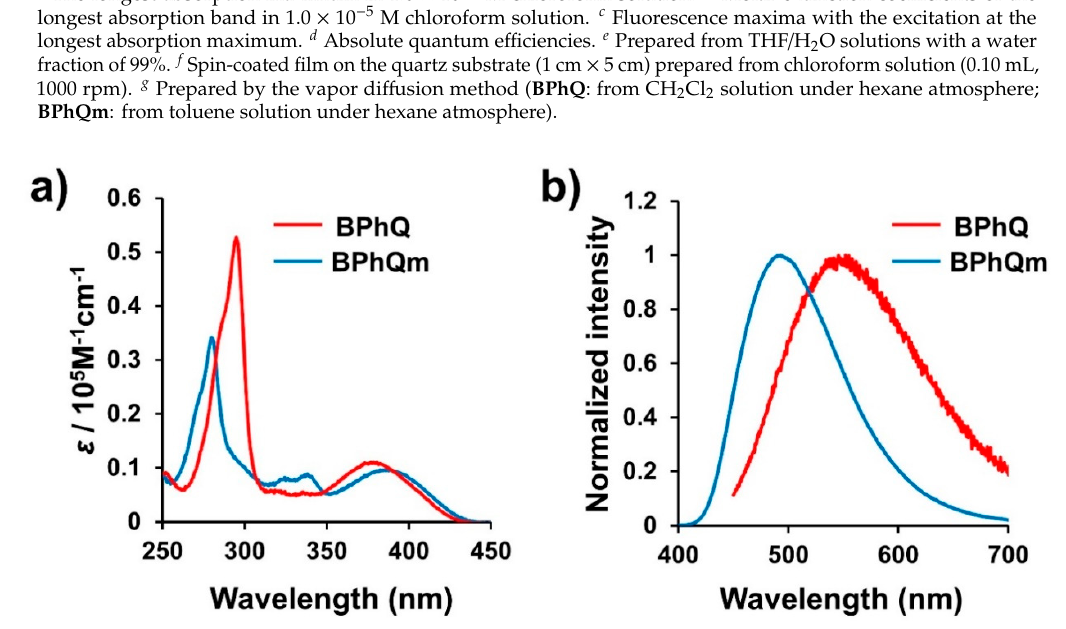
Figure 2. (a) UV–vis absorption and (b) photoluminescence spectra of BPhQ and BPhQm (1.0 × 10 − 5 M chloroform solution). chloroform